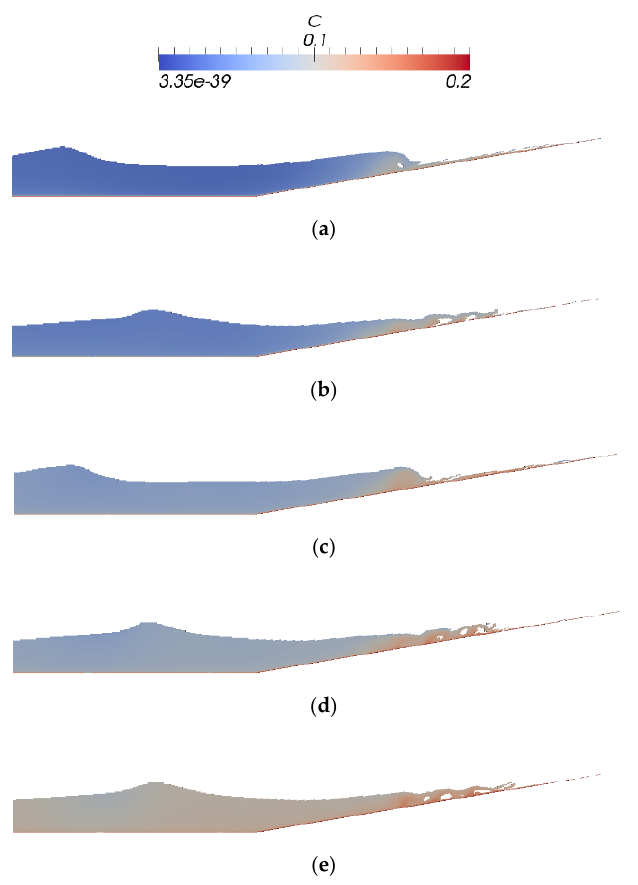
Figure 9. Sequential snapshots of numerically simulated suspended sediment concentration [Run 2].